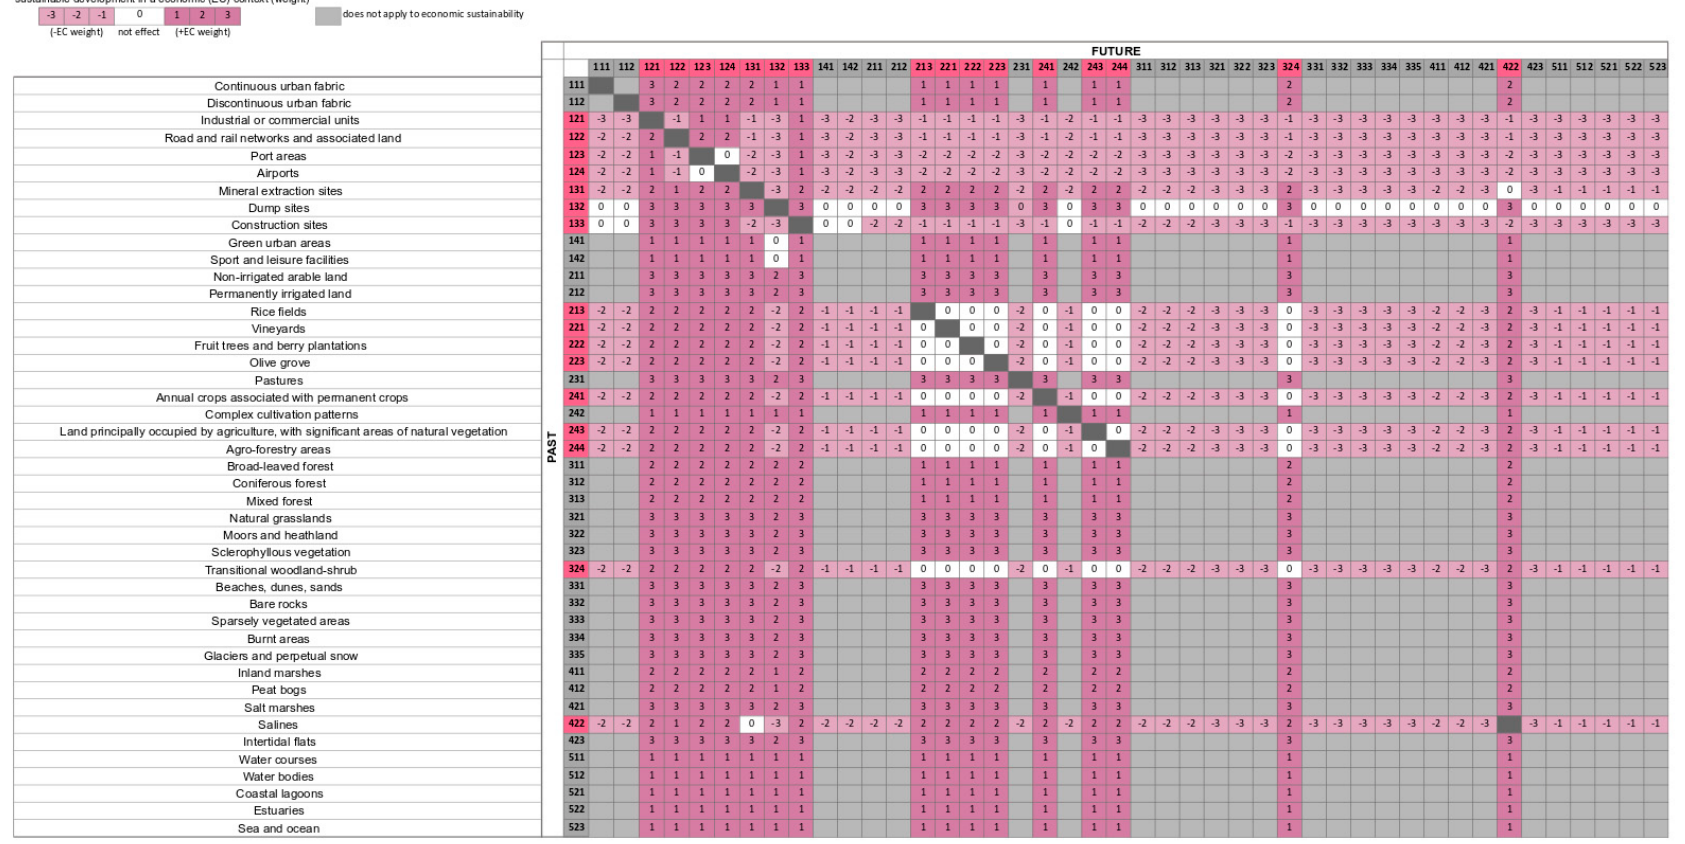
Figure A1 . Land use change assessment matrix in the economic aspect. Figure A1. Land use change assessment matrix in the economic